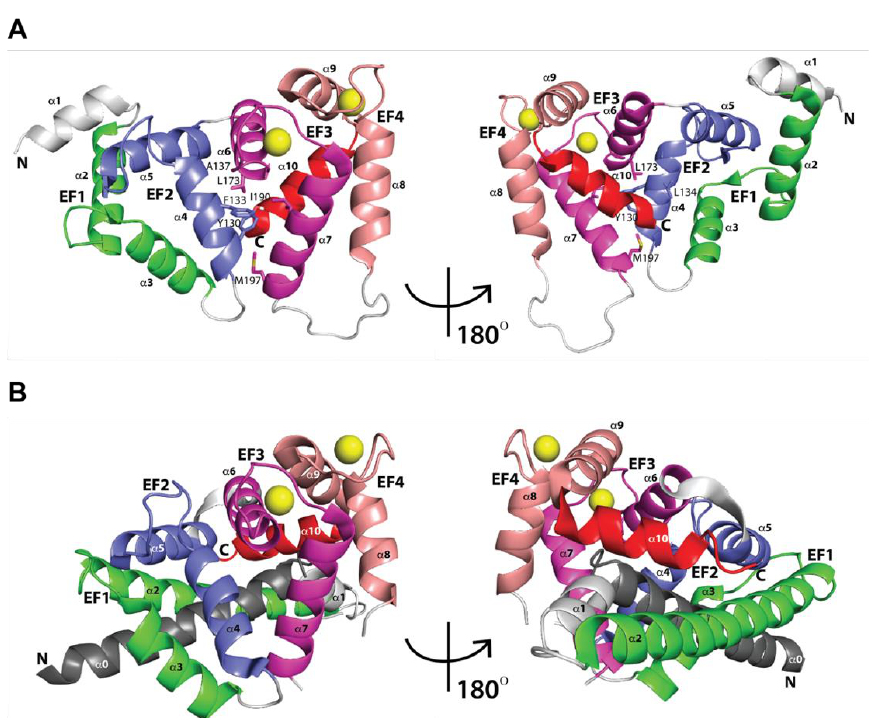
Figure 3. Three-dimensional structures of free KChIPs. The four EF-hand motifs are shown, as representative examples: ( A ) KChIP3 (PDB ID 2JUL) [51] and ( B ) KChIP4a (PDB ID 3DD4) [52]. Different from KChIP1-3, KChIP4a C-terminal α-helix H10 (red) swings outward at ~45° from the hydrophobic pocket. Ca 2+ ions are shown as yellow spheres.